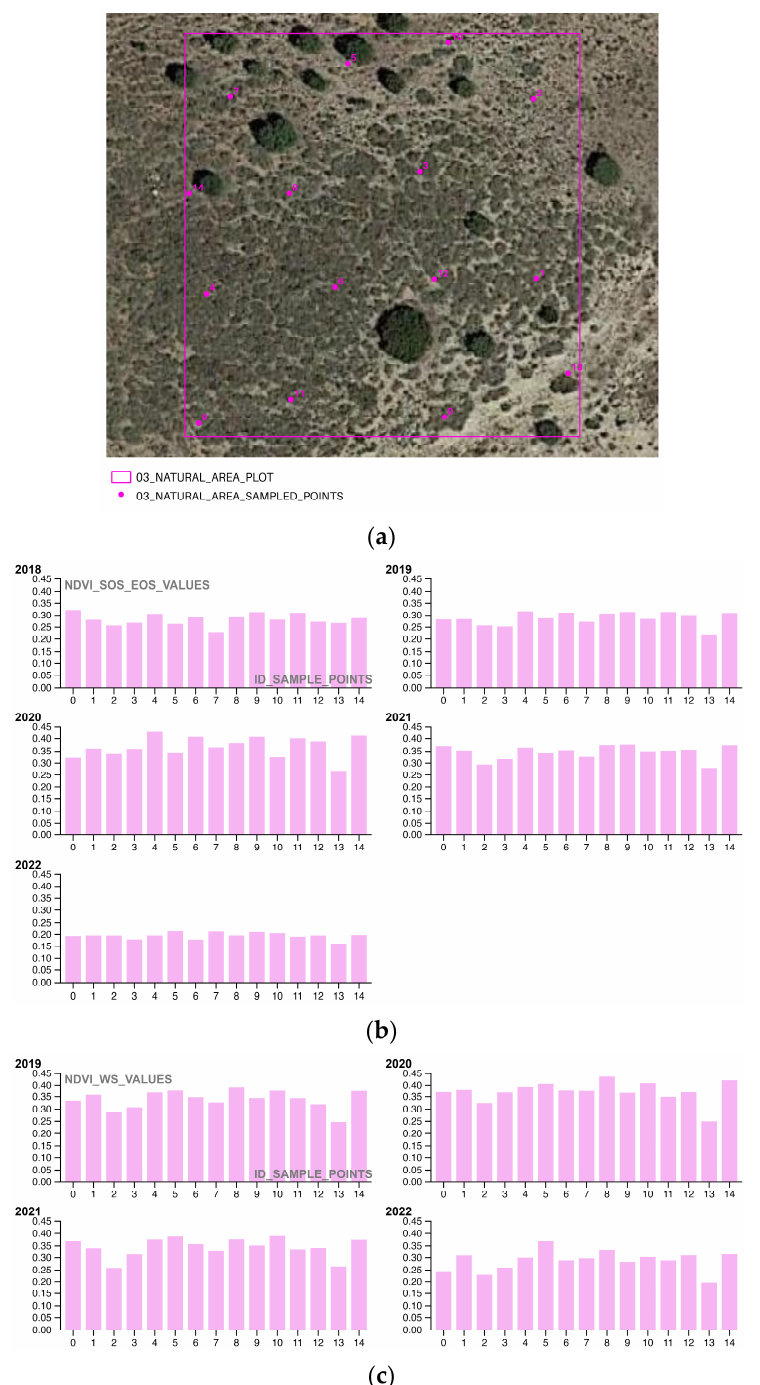
Figure 18. ( a ) 03_NATURAL_AREA_PLOT.shp samples the COPERNICUS/S2_SR NDVI values of a portion in the upper AOI that was reforested with landscape restoration techniques and left to natural management without human interference; ( b ) the COPERNICUS/S2_SR NDVI vegetation trends SOS-EOS phenological growth rate of the sample points (2018–2022) shows the annual trend of vegetation activity during the growing season, from the start of the growing season (SOS) to the end of the growing season (EOS); ( c ) the COPERNICUS/S2_SR NDVI vegetation trends WS phenological growth rate of the sample points (2018–2022) shows the vegetation activity during the winter season (WS).